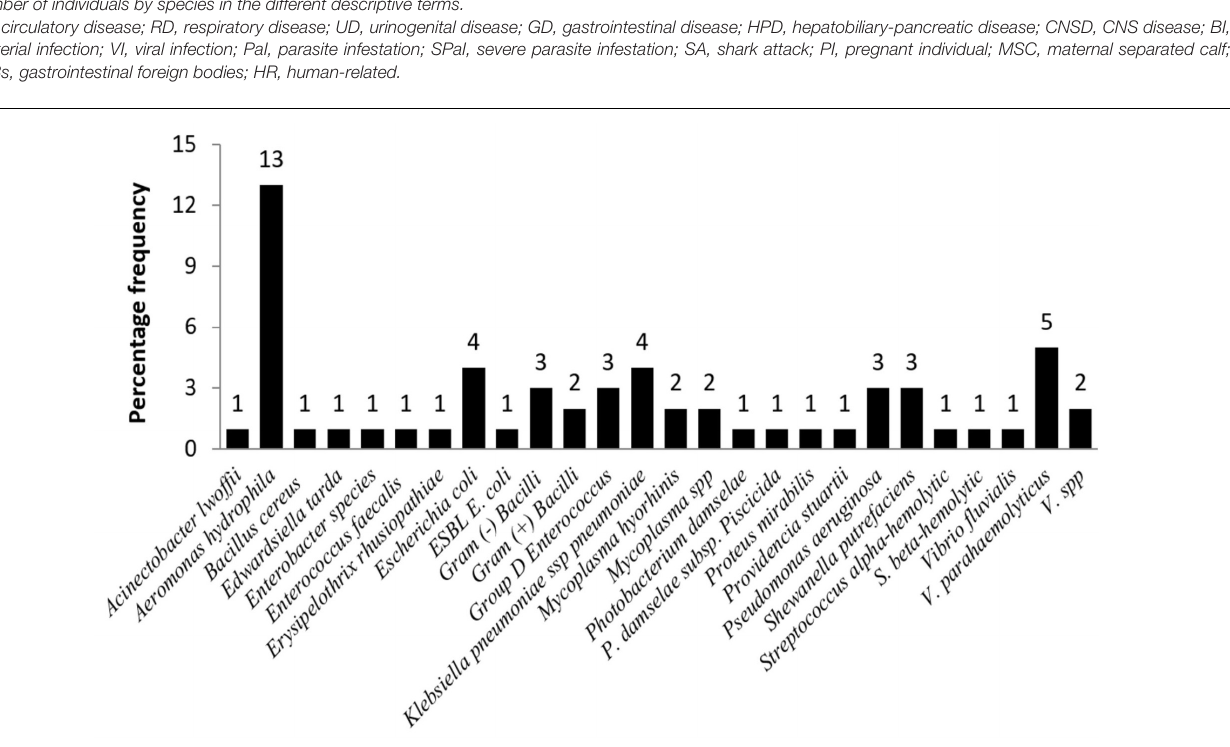
FIGURE 2 | Frequencies of bacterial isolates from stranded